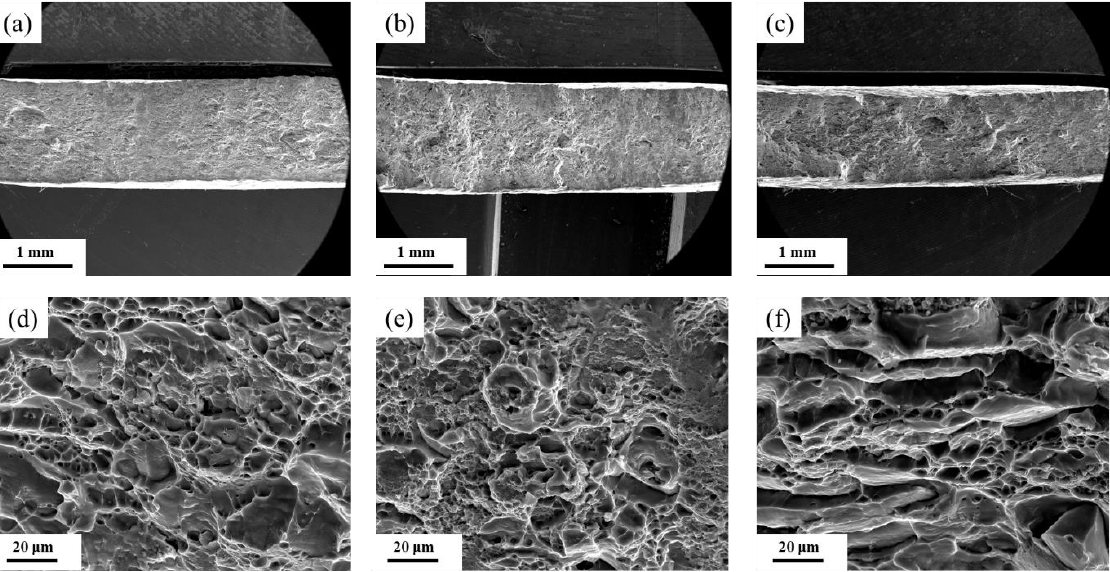
Figure 11. Fracture surface characteristics of 7085 alloys after tension tests: ( a , d ) HTD; ( b , e ) MTD; ( c , f ) CTD.